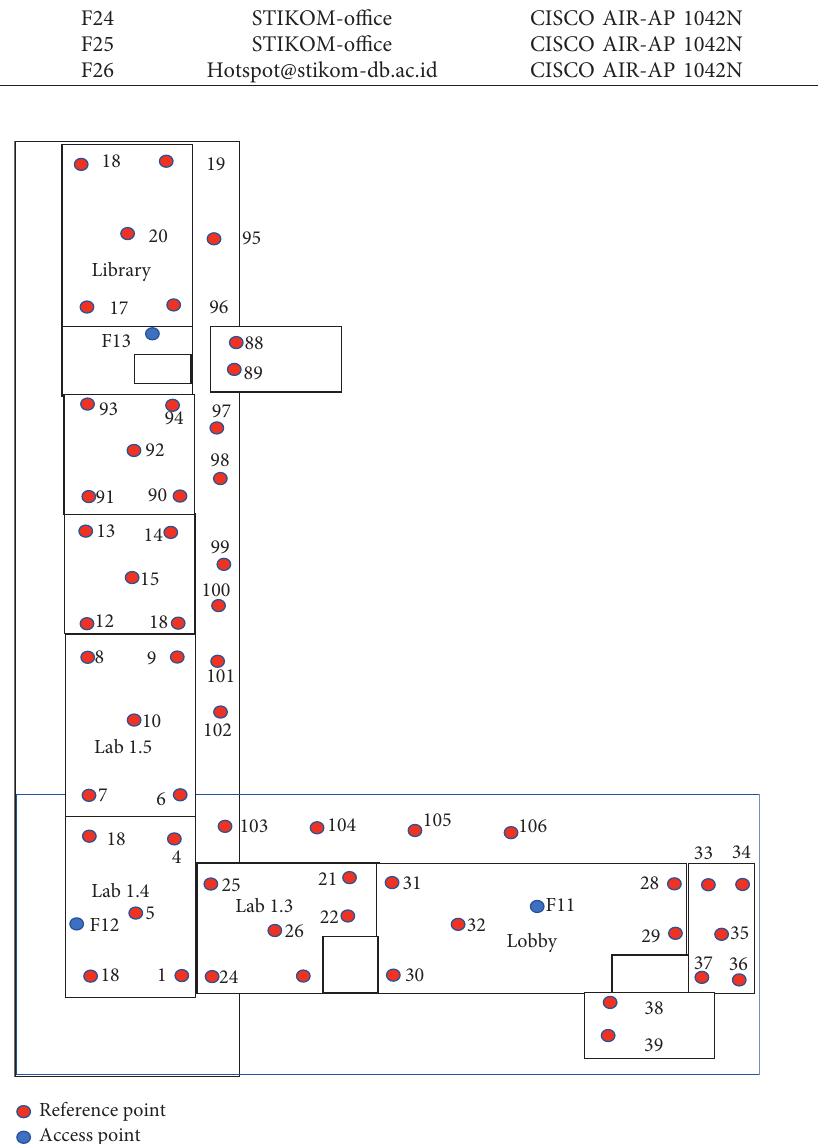
Figure 1: The AP position and reference point design on floor